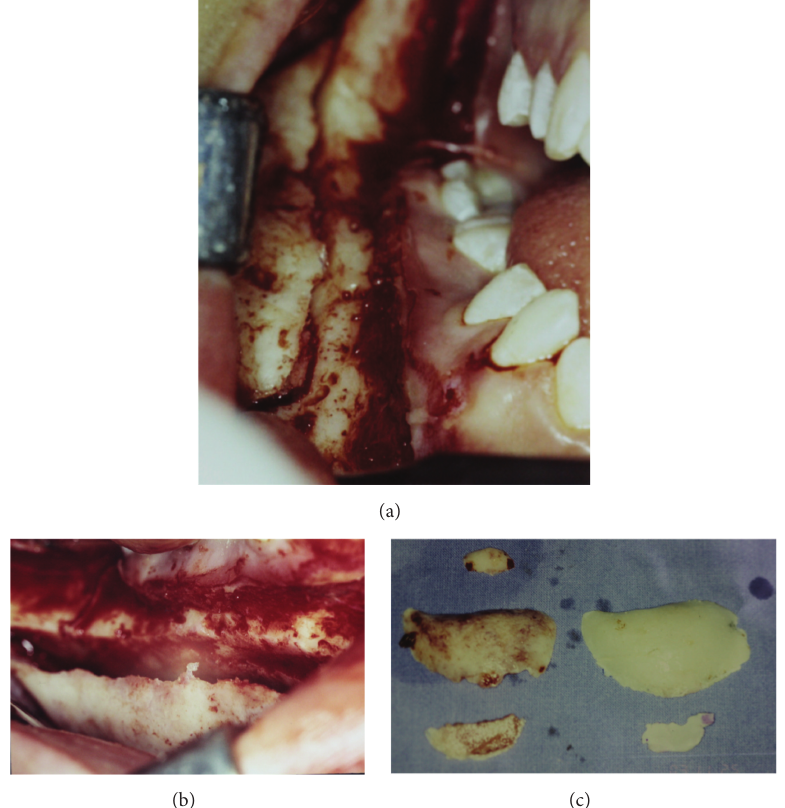
Figure 4: (a and b) Photographs of the surgical procedure; (c) photograph of surgical pieces removed.